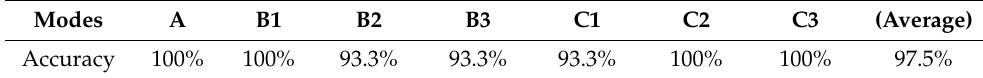
Table 13. Diagnosis